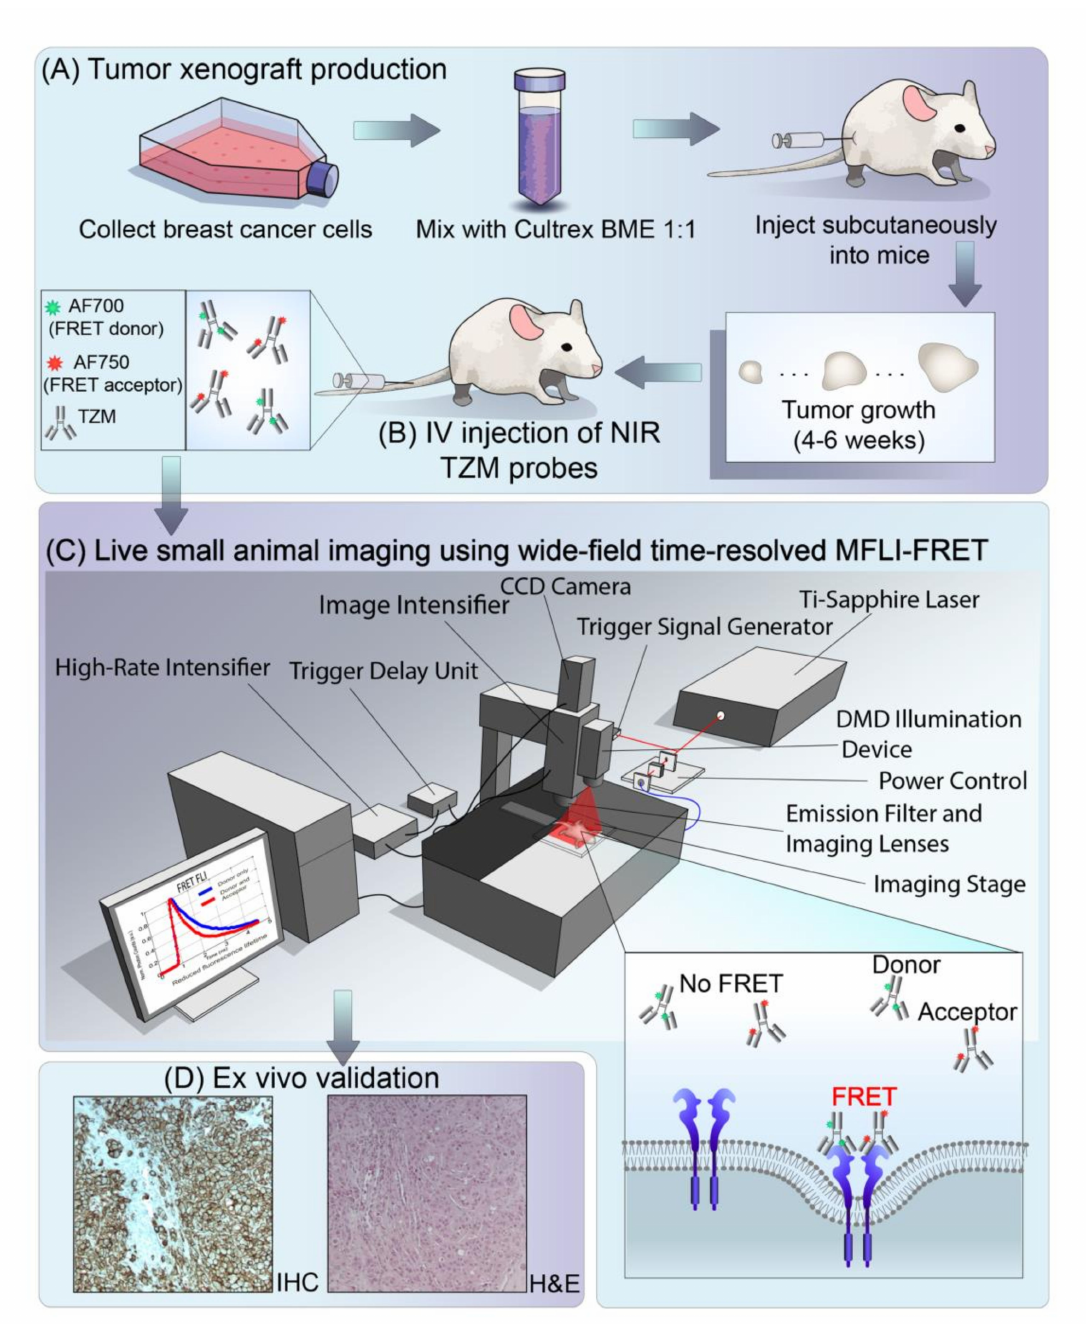
Figure 5. Schematic representation of live small animal NIR wide-field time-resolved macroscopic fluorescence lifetime FRET imaging (MFLI-FRET) for preclinical studies. ( A ) AU565 tumor xenograft production; ( B ) Intravenous tail-vein injection of AF700–TZM and / or AF750–TZM; ( C ) Live small animal imaging using wide-field time-resolved FLI-FRET macroscopy (MFLI-FRET) imager; ( D ) Ex vivo validation using immunohistochemical (IHC) and H&E staining. Inset top left: illustration of TZM–AF700 and TZM–AF750 ligands. Inset bottom right: illustration of TZM–HER2 FLI-FRET events upon binding of donor- and acceptor-labeled antibodies to HER2 dimer at the surface of cancer cells. DMD: digital micromirror device; CCD: charge-coupled